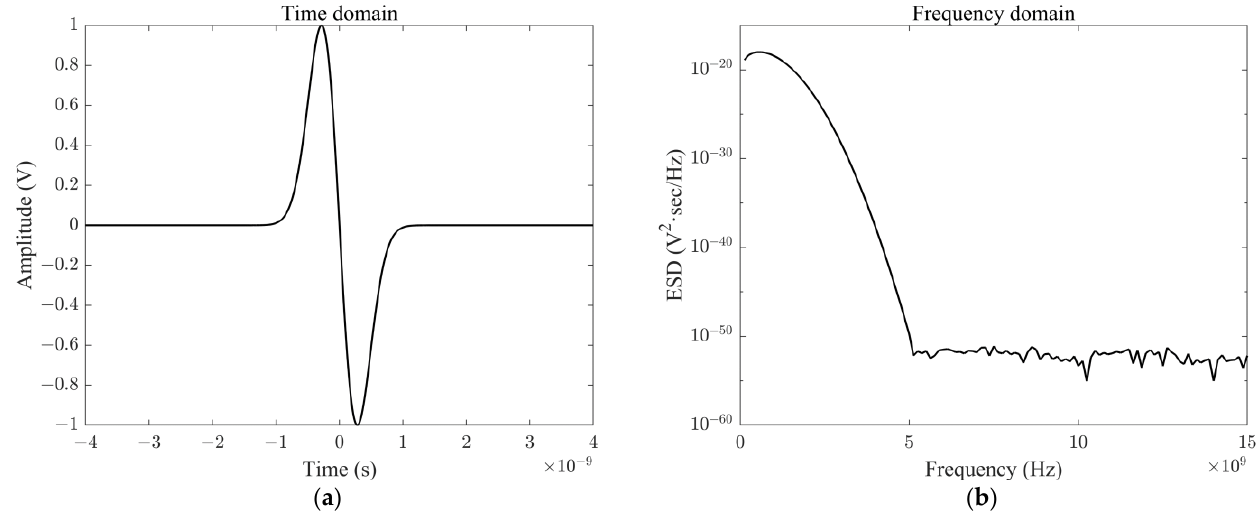
Figure 3. UWB characteristic waveform: ( a ) time domain; ( b ) frequency domain.